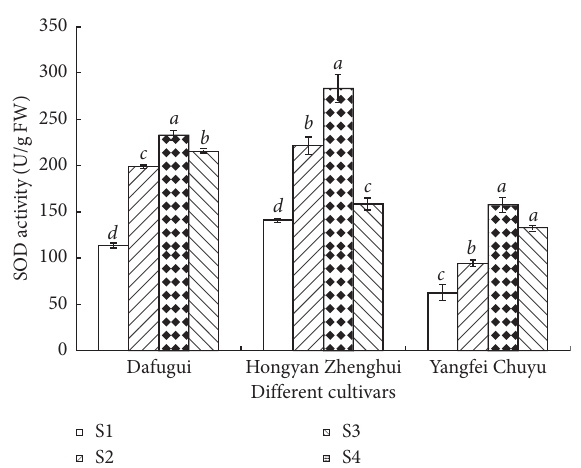
Figure 8: SOD activity of developmental P. lactiflora petals (U/g FW). Different letters within each cultivar indicated significant differences at 5%